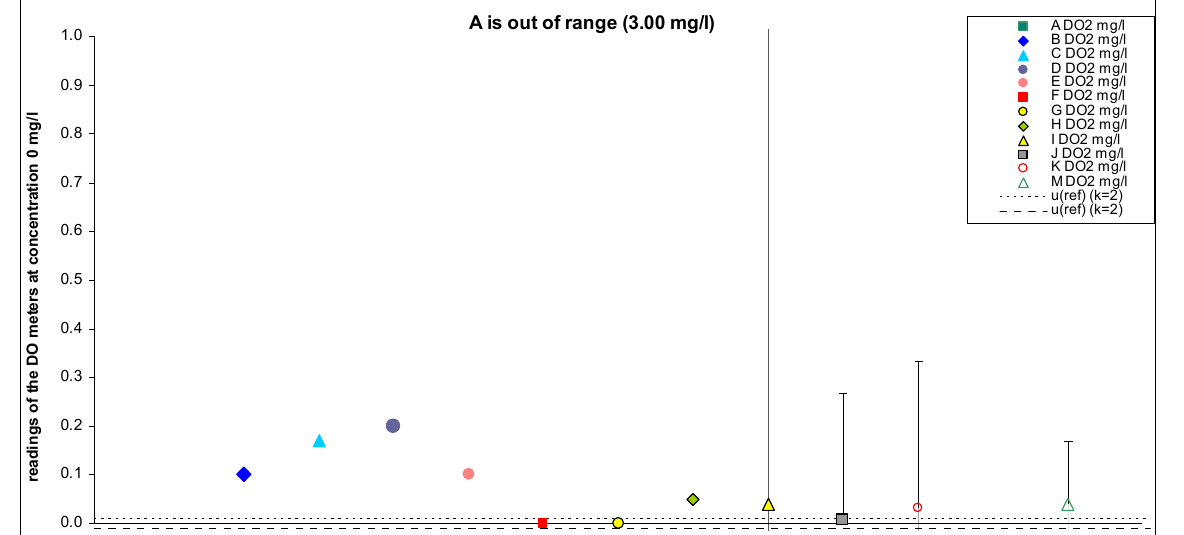
A is out of range (3.00